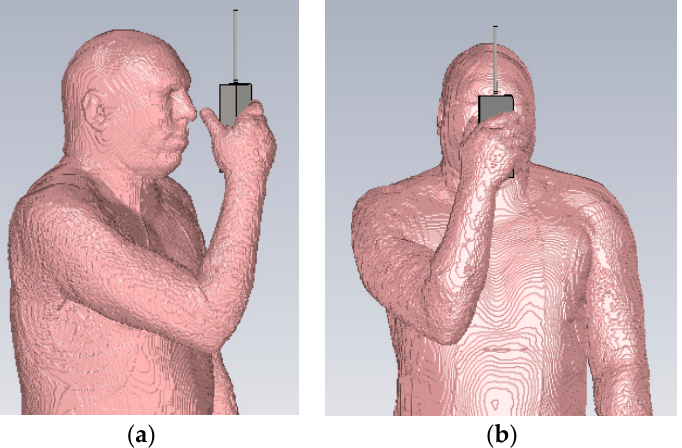
Figure 3 . The computer model of a human using a radiophone: ( a ) side view; ( b ) front